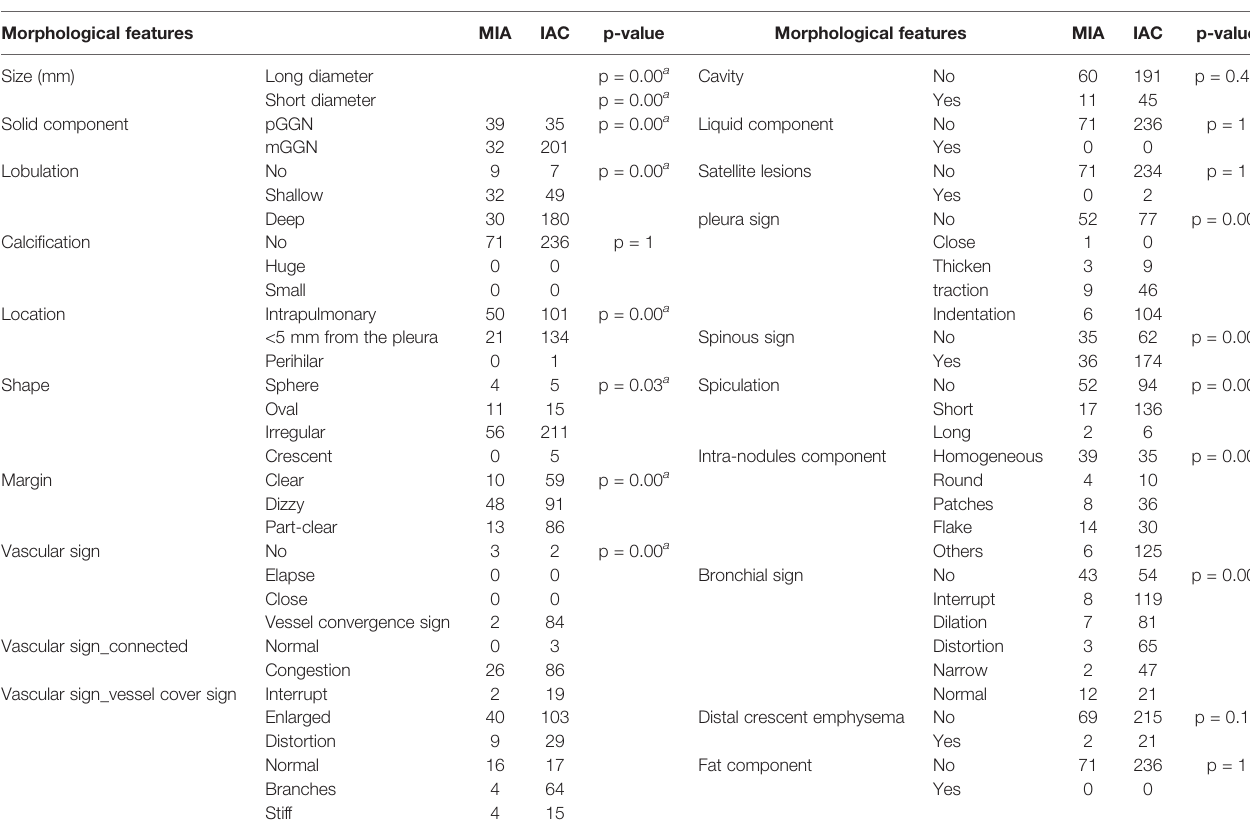
a Indicates the difference was statistically signi fi